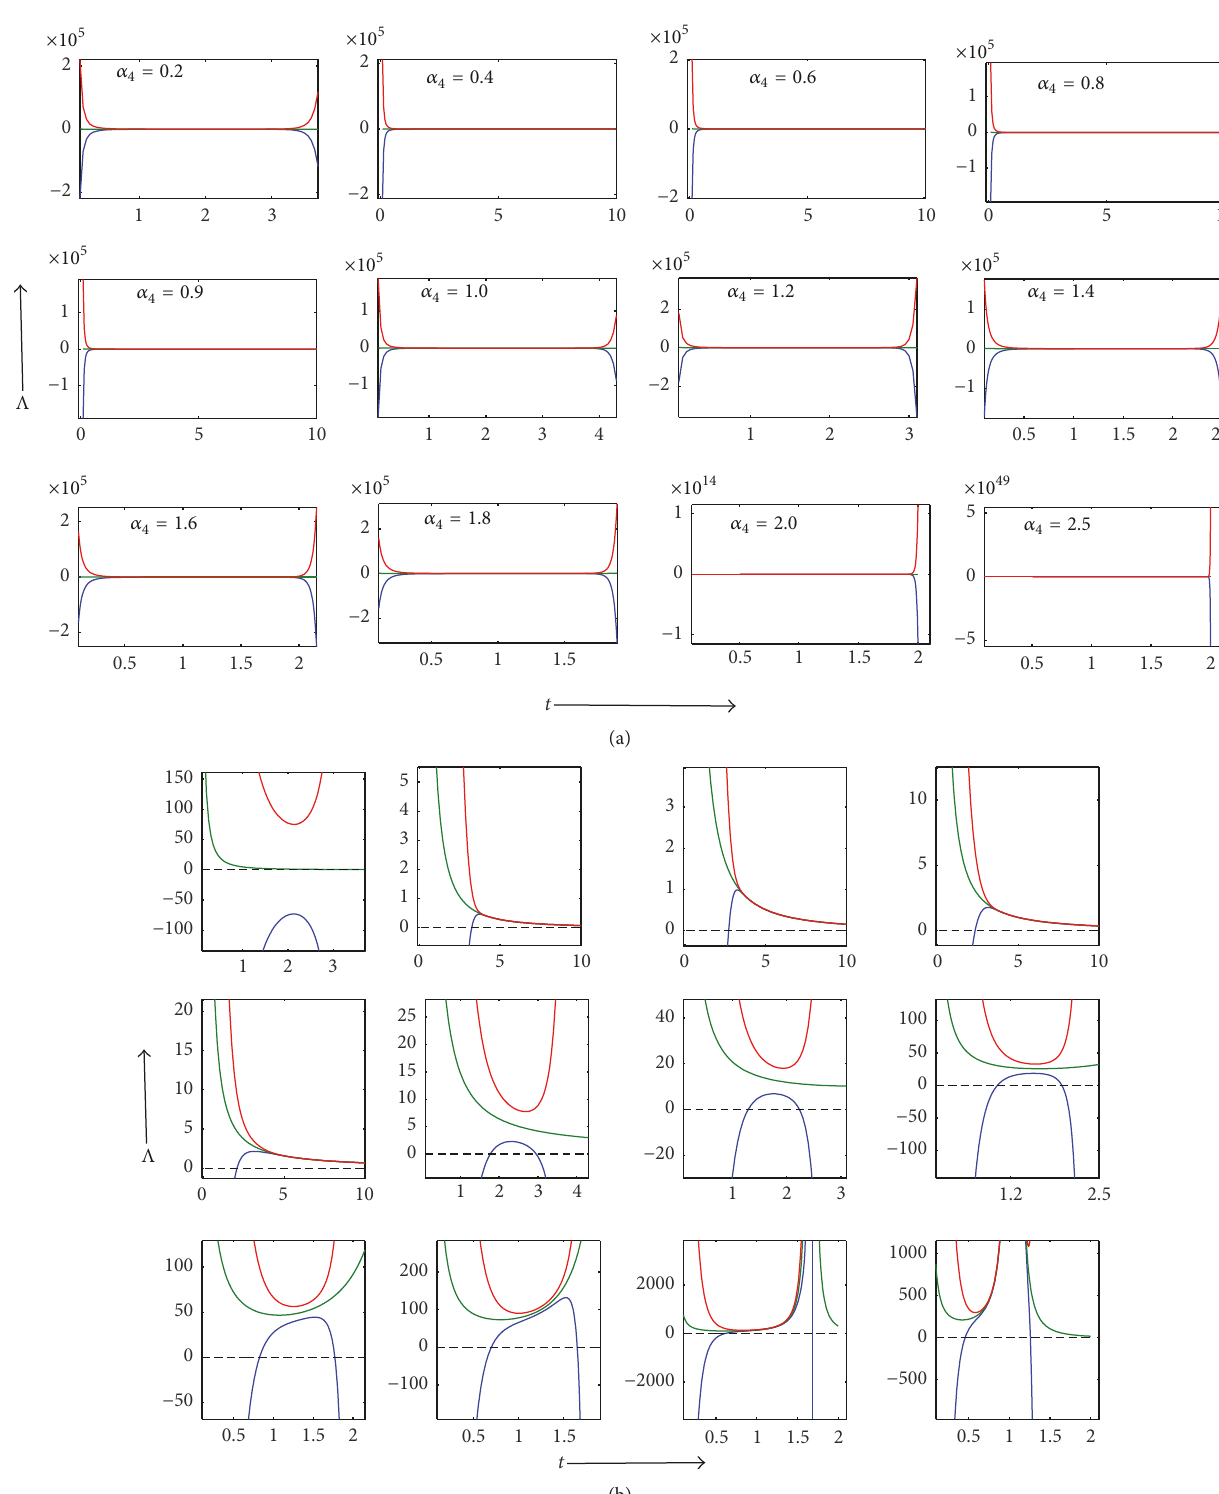
Figure 17: Variation of cosmological constant Λ against time for 𝛼 1 = 0.5 , 𝛼 5 = 0.3 , 𝜔 = 1 , 𝑐 2 = 0.1 , and different 𝛼 4 . (b) shows the zooming of (a). Blue line, Green line, and Red line represent 𝑘 = −1 , 𝑘 = 0 , and 𝑘 = 1 ,